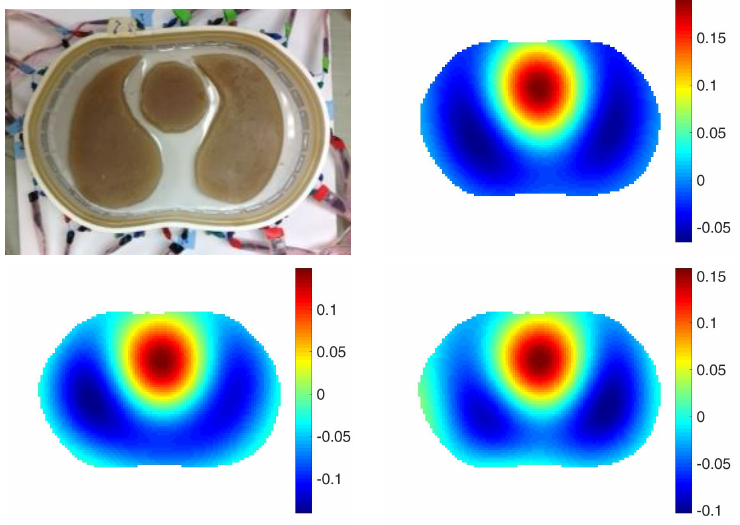
Figure 1. Top left: The chest shaped tank filled with saline bath and inclusions simulating two low conductive lungs and the high conductive heart. Top right: A difference image without modeling the location of electrodes. Bottom left: A difference image with modeling the location of electrodes. Bottom right: An absolute image with modeling the location of electrodes. The L2 norms of the differences between those reconstructions and the ground truth are 0.1128, 0.0973 and 0.0981 in